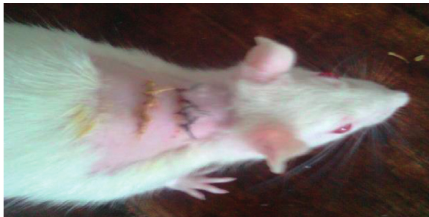
Figure 2: SD rat sutured with immature coconut fiber and silk